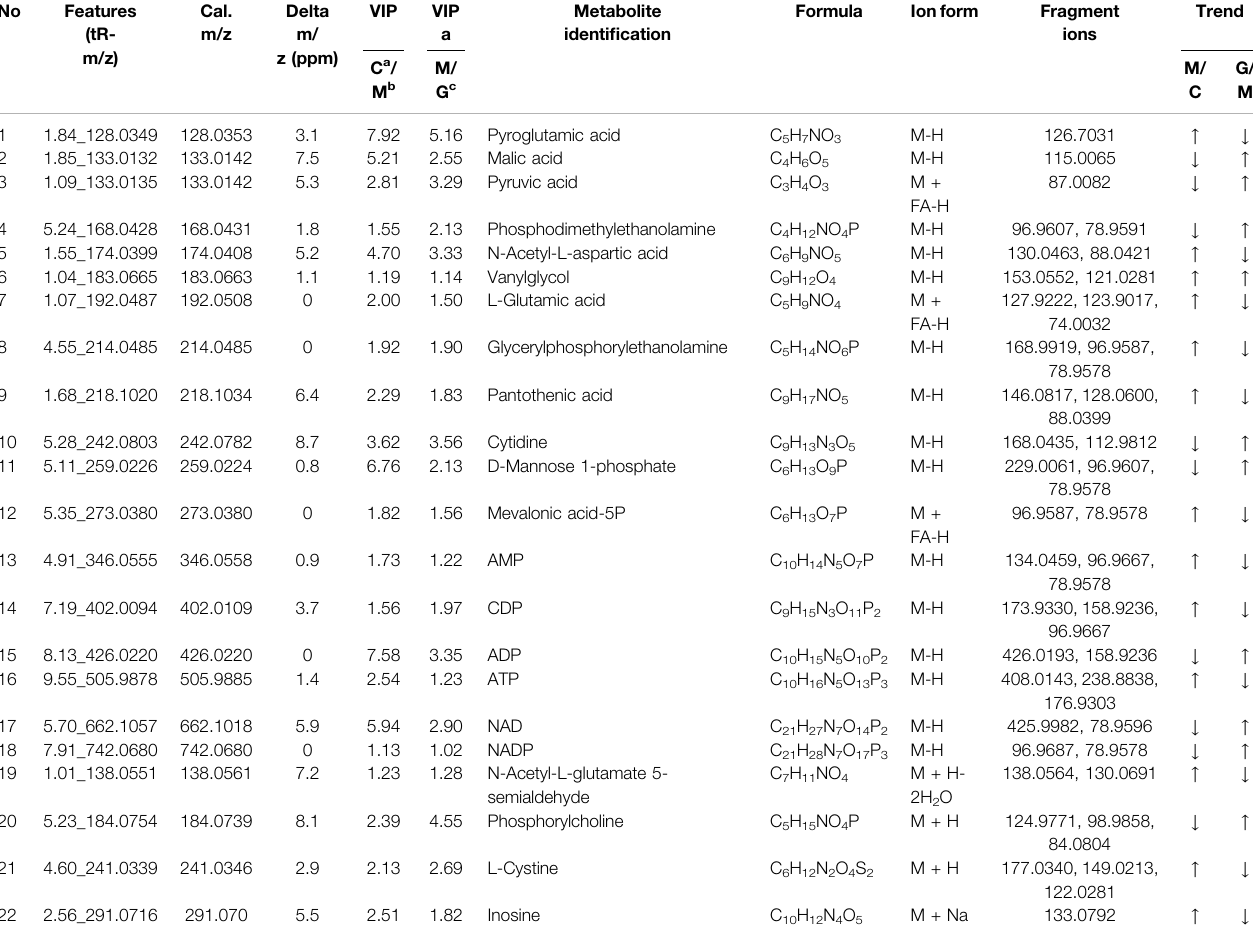
Formula Ionform Fragment